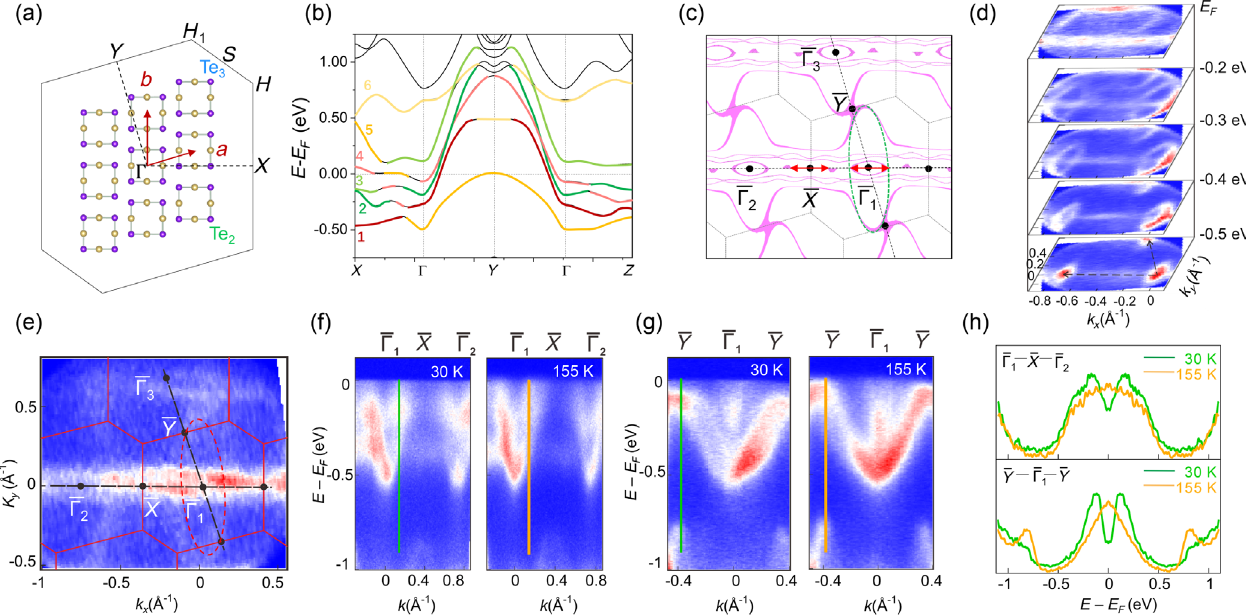
FIG. 3. Electronic structure of the ATS crystal. (a) Two-dimensional BZ of an ATS crystal surface (the a - b plane) and the corresponding structural model in real space. a and b represent the lattice vectors. (b) Theoretical band structure of bulk ATS along highly symmetric lines. Bands 1 – 6 are numbered according to their orders of eigenenergies at the X point (see Supplemental Material Fig. S6 [38]). (c) Constant-energy contours in the 2D Brillouin zone ( k z ¼ 0 ) at the adjacent Fermi level with an energy broadening of (cid:4) 8 meV. The red arrows indicate two typical nesting vectors relevant with the TCCDW. (d) Constant-energy intensity plots with respect to the Fermi level obtained from ARPES measurements. Two high-symmetry paths ( Γ - X - Γ and Γ - Y - Γ ) are indicated using two black dashed lines at the − 0 . 5 eV plane. (e) Integrated intensity plot with E F (cid:4) 40 meV. The large elliptical FS is marked using a red dashed line. (f),(g) Two-dimensional intensity plots measured along Γ 1 - X - Γ 2 (f) and Y - Γ 1 - Y (g) at T ¼ 30 K (left) and T ¼ 155 K (right), respectively. (h) The symmetrized energy distribution curves at 1 = 3 ( Γ - X ) and the Y point from (f) and (g), as measured at 30 K (green) and 155 K (orange),